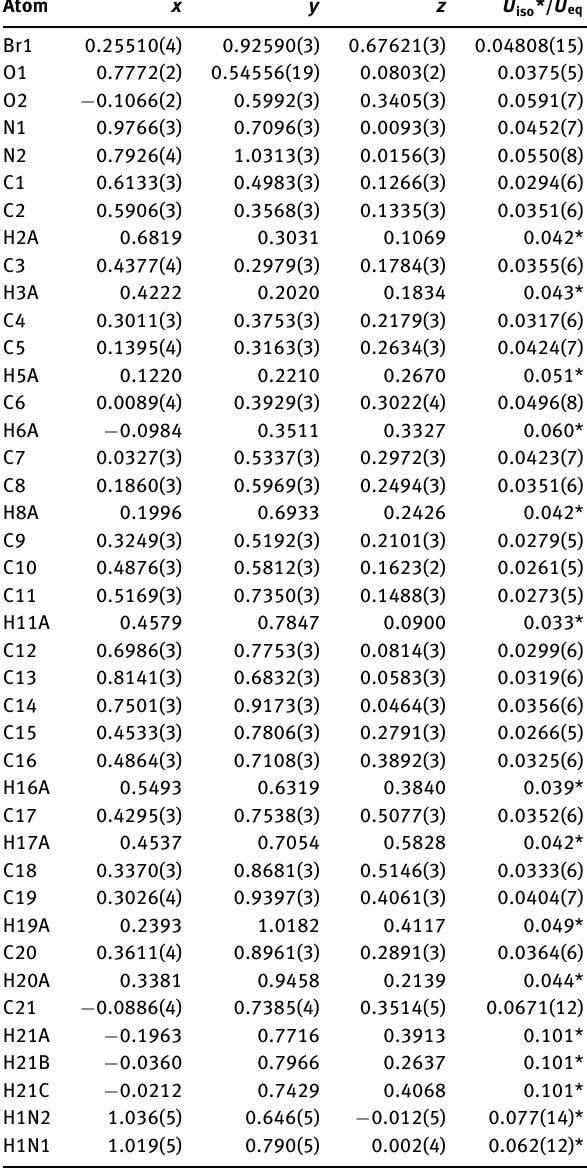
Table 2: Fractional atomic coordinates and isotropic or equivalent isotropic displacement parameters (Å 2